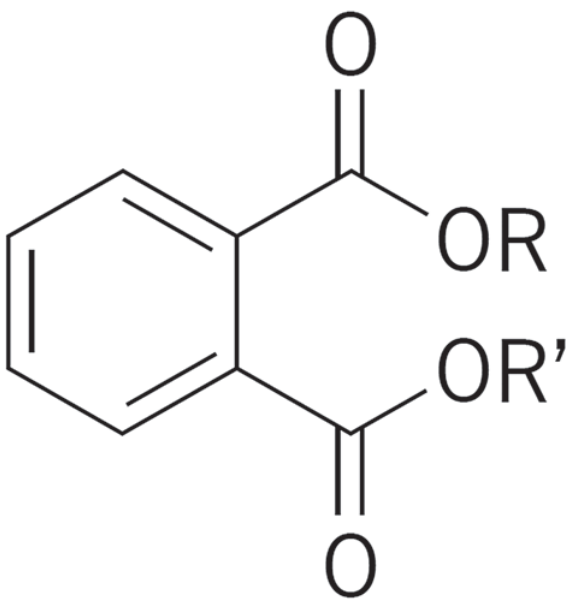
Figure 2 – Generic diester